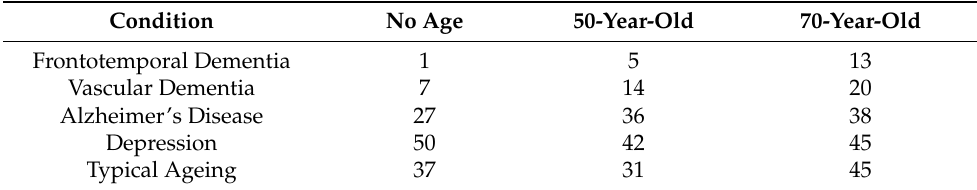
Table 3. Proportion of correct responses to the